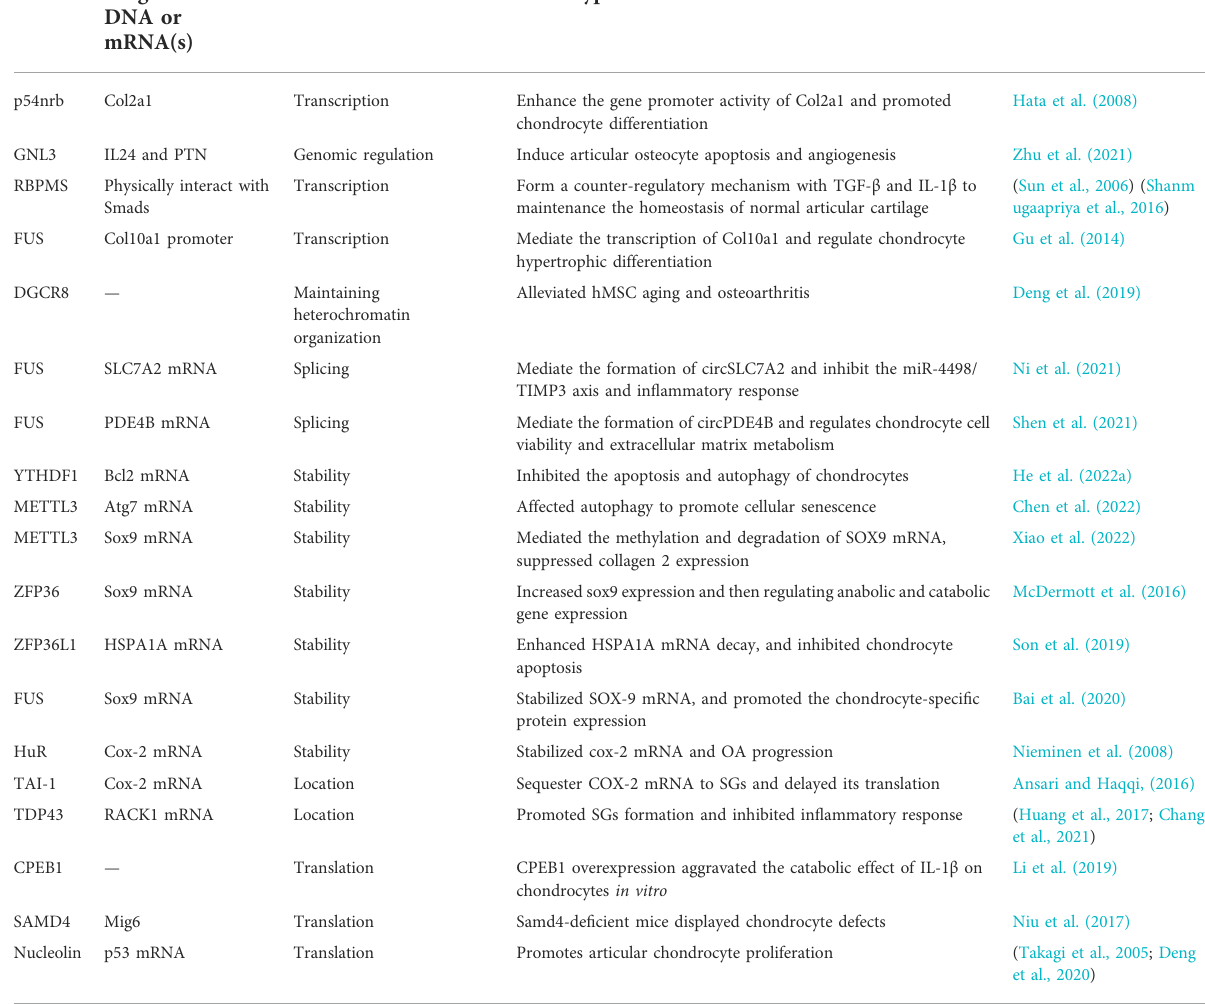
TABLE 1 General overview of osteoarthritis-related RNA-binding proteins and their